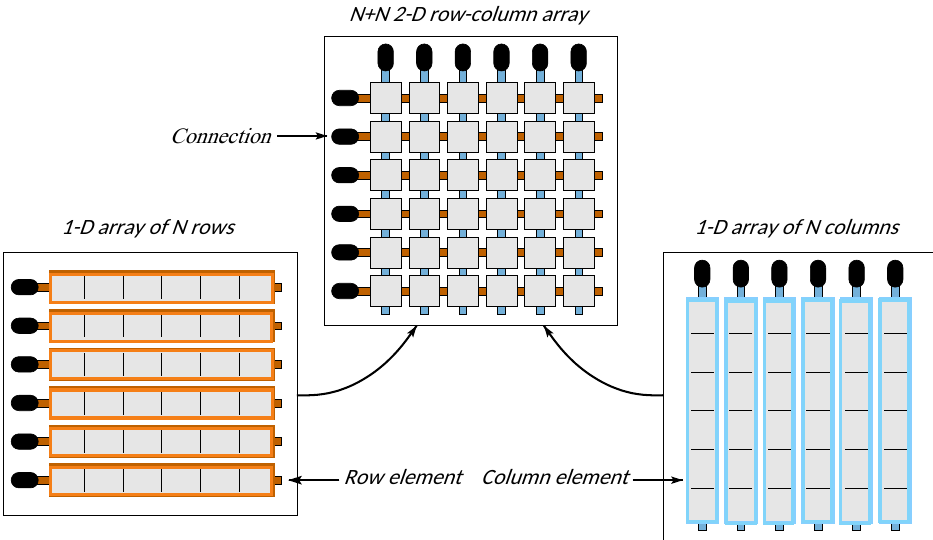
Figure 2. Two 1D arrays (1 × N and N × 1) are mounted orthogonally on top of each other to form 2D RC-addressed N + N